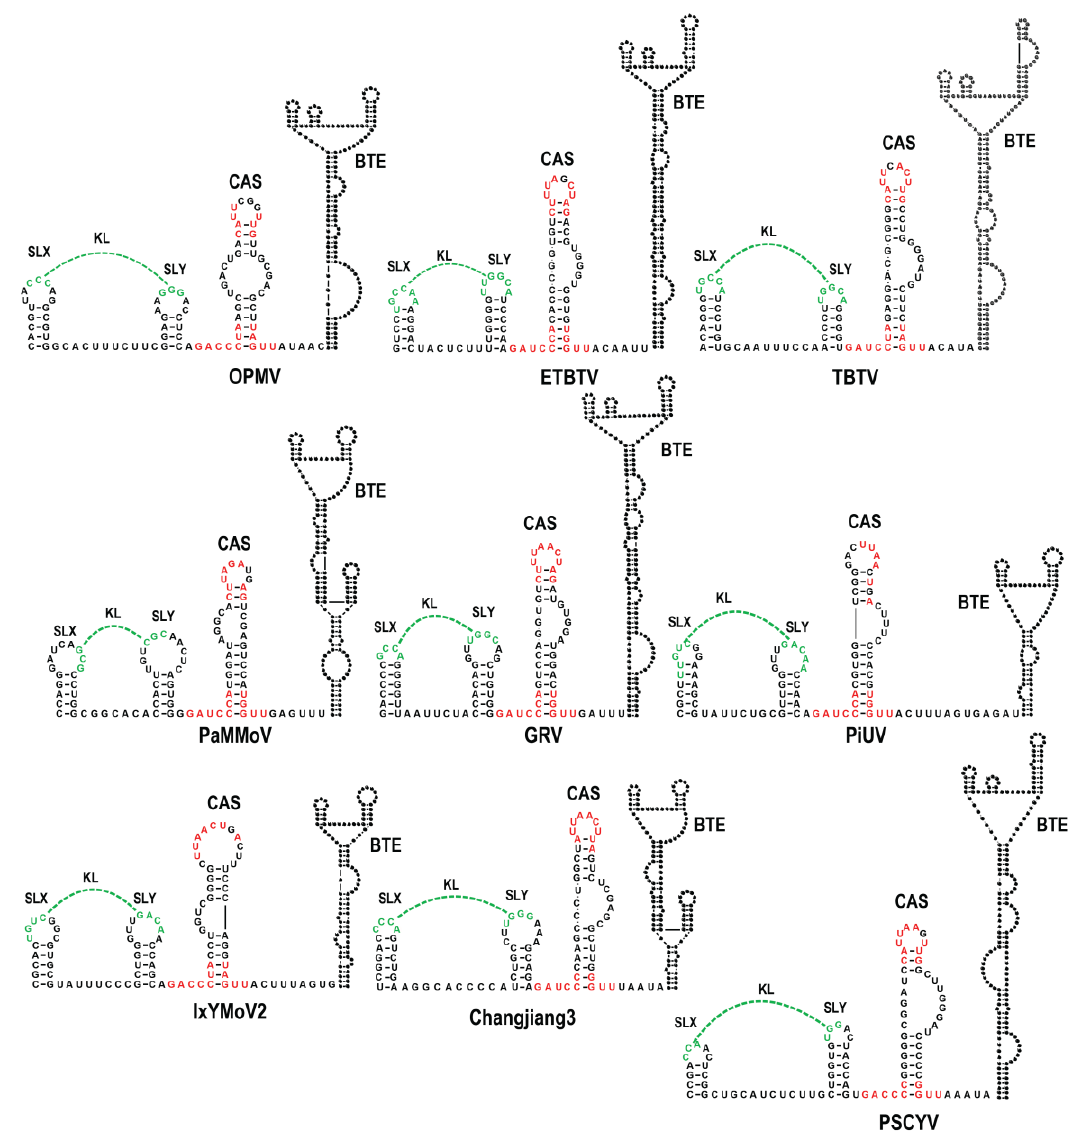
Figure 2. Predicted structures in the central region of umbraviruses containing BTE 3ʹCITEs. Con- served CAS sequences are in red. KL sequences are in green. Each BTE dot represents a nucleotide.